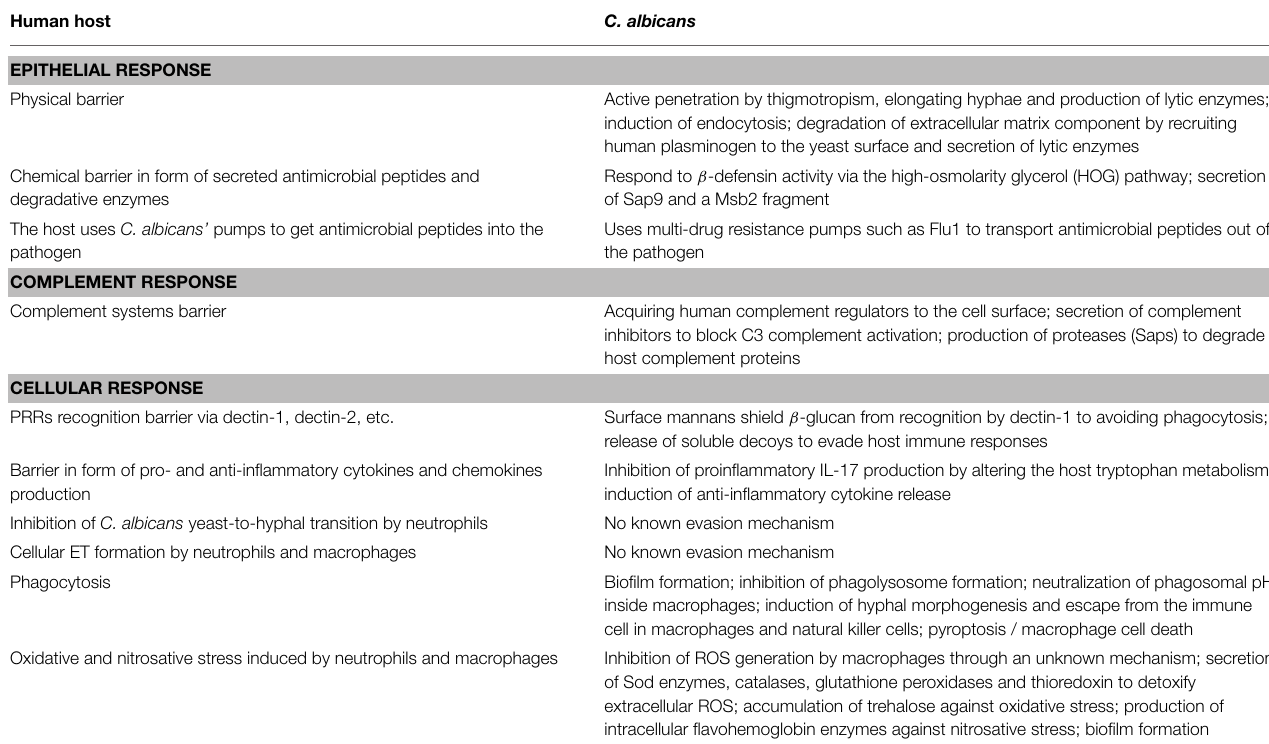
TABLE 2 | Pairs of defense and evasion strategies— C. albicans and the human innate immune